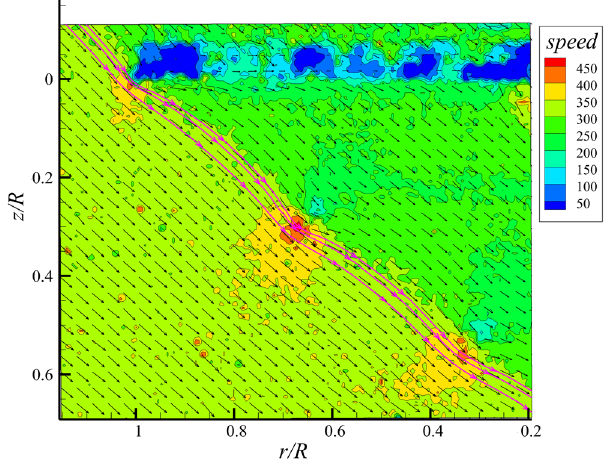
Figure 13. Tip vortex shedding trajectory at 𝜓 = 180° .